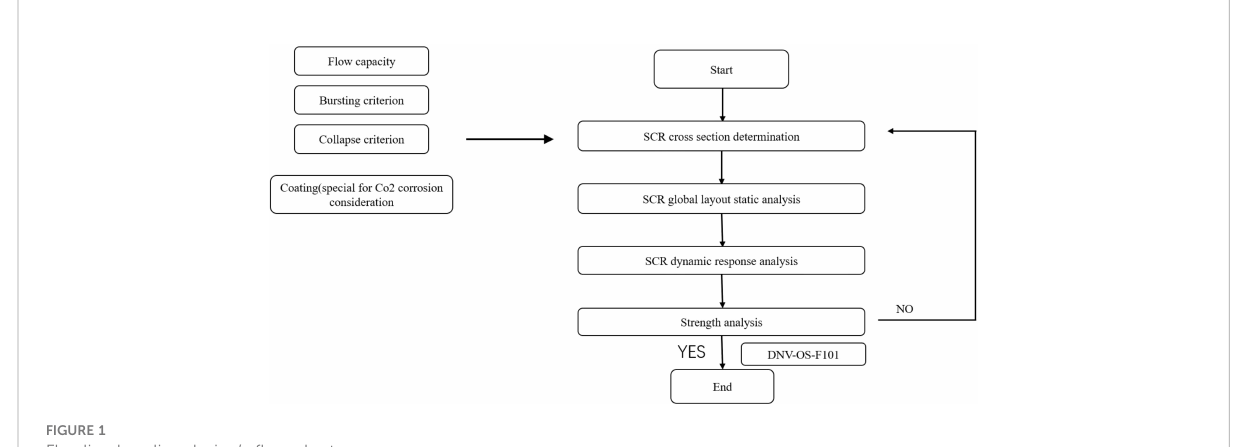
FIGURE 1 Flowline baseline design ’ s fl ow